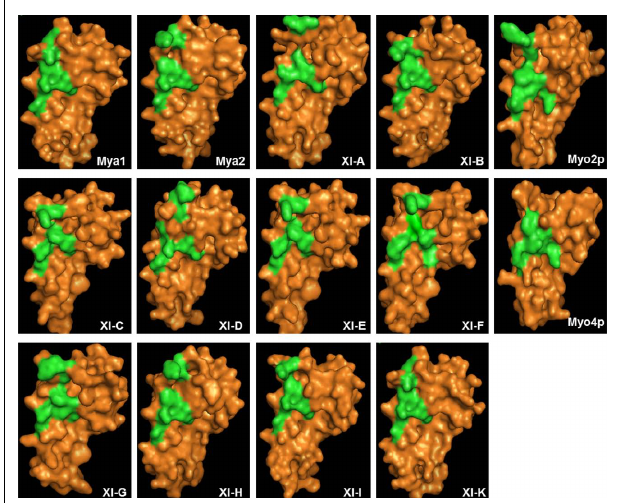
FIGURE 7 | Structural modeling of myosin XI DIL domain based on similarity to the myosinV ScMyo4p. Predicted three-dimensional structures of the DIL domain of A. thaliana class XI myosins are illustrated. Surface residues are shown in orange.The amino acids critical for secretory-vesicle binding (Catlett et al., 2000) and peroxisome inheritance in ScMyo2p tail (Fagarasanu et al., 2009) and the corresponding amino acids in DIL domains of class XI myosins are shown in